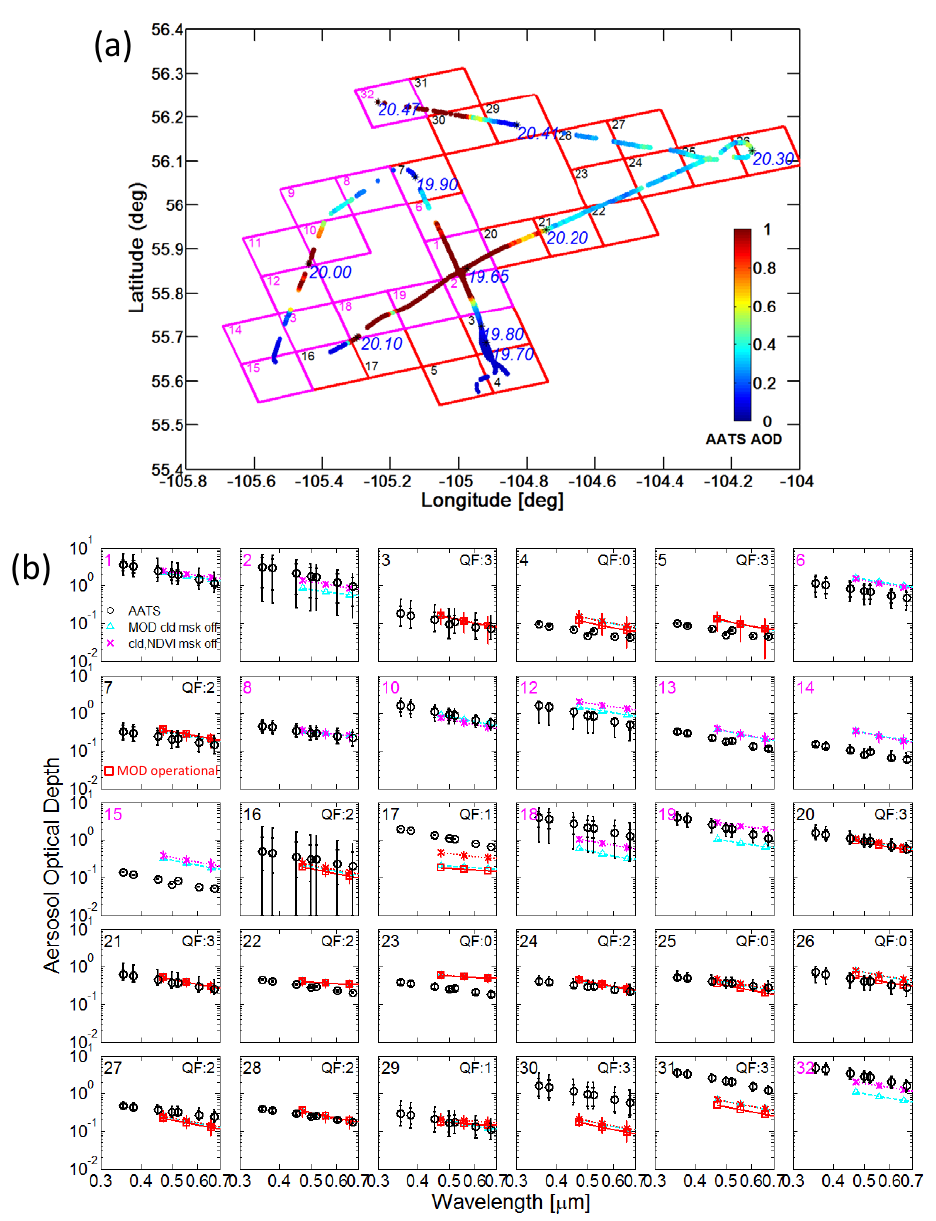
Fig. 5. For 2 July: (a) overlay of color-coded (by AATS 520nm AOD) P-3 flight track and locations of the MODIS 10km grid cells for retrievals with (red cell boundaries with black cell numbers) and without (magenta cell boundaries and numbers) the aerosol cloud mask (or the cloud and NDVI masks); (b) unadjusted AATS and MODIS AOD spectra. As explained in the text, retrieval quality flags are valid and shown only for MODIS operational retrievals.